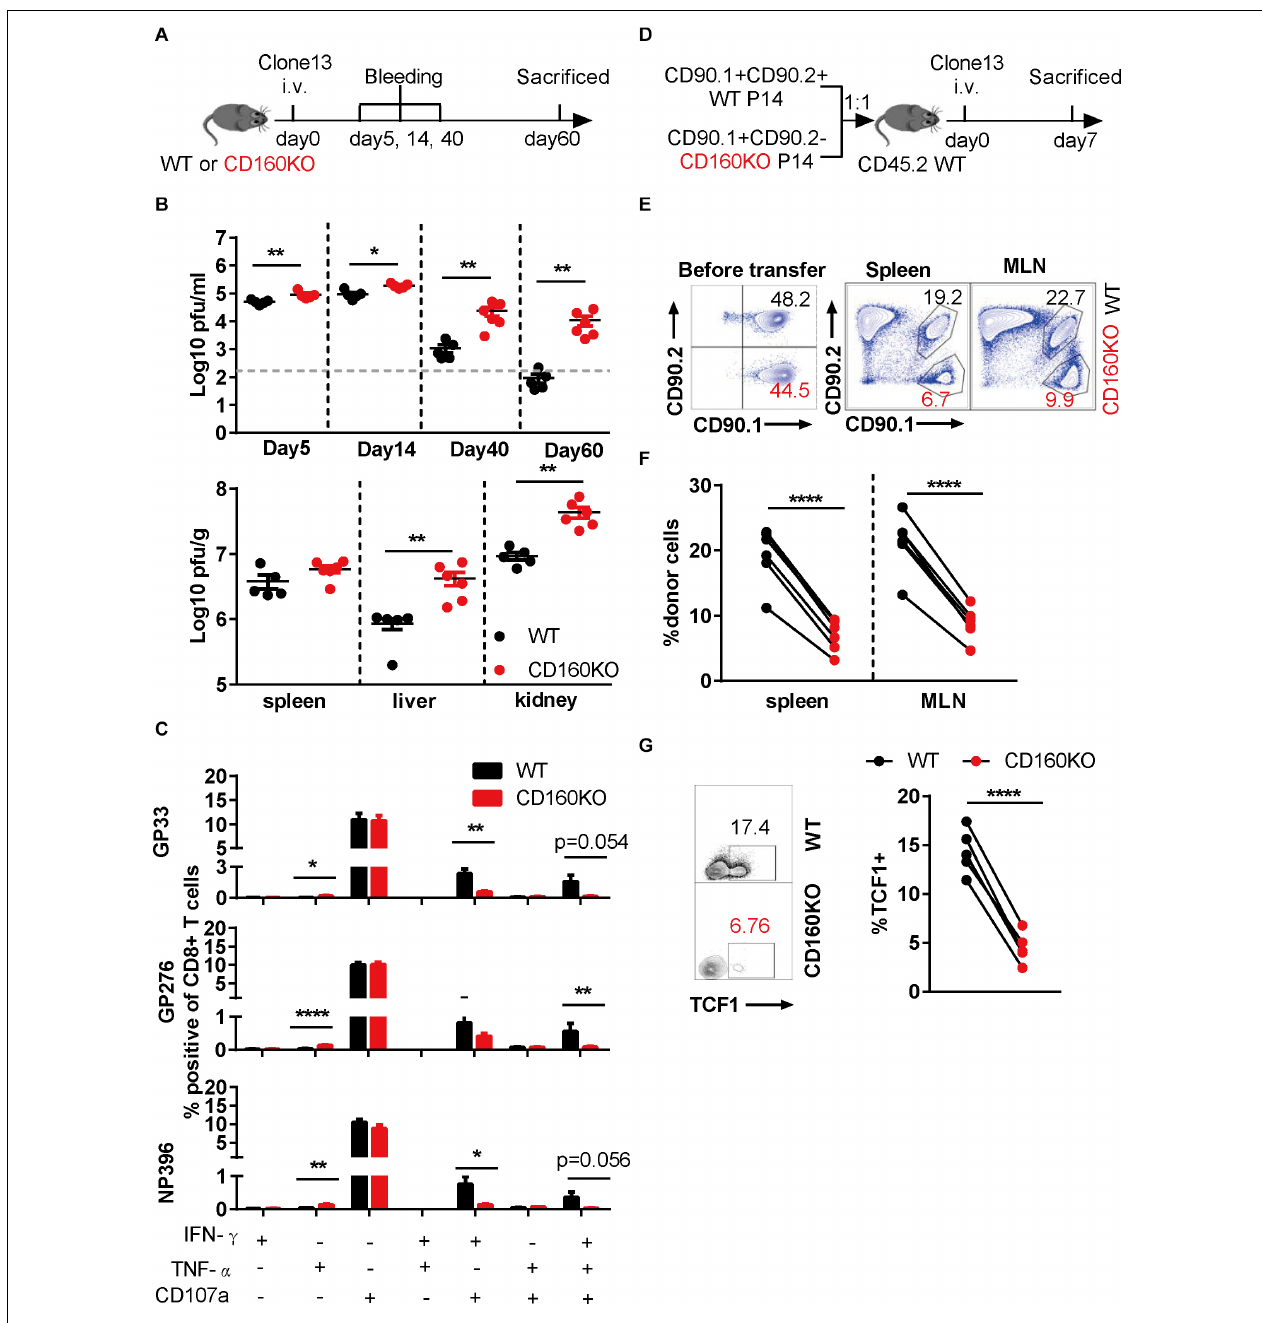
FIGURE 4 | Genetic ablation of CD160 resulted in the intrinsic impairment of CD8+ T cell function during chronic lymphocytic choriomeningitis virus (LCMV) infection. (A–C) WT and CD160KO mice were infected with LCMV Clone 13 as scheduled in (A) ; plasma viral loads were quantified on days 5, 14, 40, and 60 post-infection (B) , upper panel), and on 60 dpi the viral loads in spleen, liver, and kidney were also measured (B) , lower panel). (C) Summarized data showing the comparison between WT and CD160KO CD8+ T cells in the yield of IFN- γ /TNF- α /CD107a single-, dual-, and triple-positive cells after LCMV-specific peptide stimulation. Splenocytes were harvested and stimulated with LCMV glycoprotein peptide (GP33 and GP276) or LCMV nucleoprotein peptide (NP396) on 35 dpi. (D) Schematic diagram of adoptive transfer experiment to determine the nature of CD8+ T cell defect in chronic LCMV infection caused by CD160 deficiency. WT (CD90.1+ CD90.2+) and CD160KO (CD90.1+ CD90.2 − ) P14 CD8+ T cells were mixed at a 1:1 ratio (5,000 cells each), adoptively transferred into congenic (CD90.1–CD90.2+) naive recipient mice, and then infected with LCMV Clone 13. (E) Representative flow cytometric plots enumerating the abundance of WT and CD160KO donor cells before transfer (left) and in the spleen and mesenteric lymph node (MLN) of the recipient mouse on 7 dpi (right). (F) Pooled data of abundance assessment of P14 donor cells in the spleen (left) and MLN (right) of the recipient mice on 7 dpi. (G) Comparison of TCF1 expression by flow cytometry on adoptively transferred WT and CD160KO P14 cells isolated from recipient mice on 11 dpi. The data in (B,C) are analyzed by Mann–Whitney U test, and paired t test is used to analyze data in (F,G) . The error bars in (B,C) denote SEM. * P < 0.05; ** P < 0.01; **** P < 0.0001.